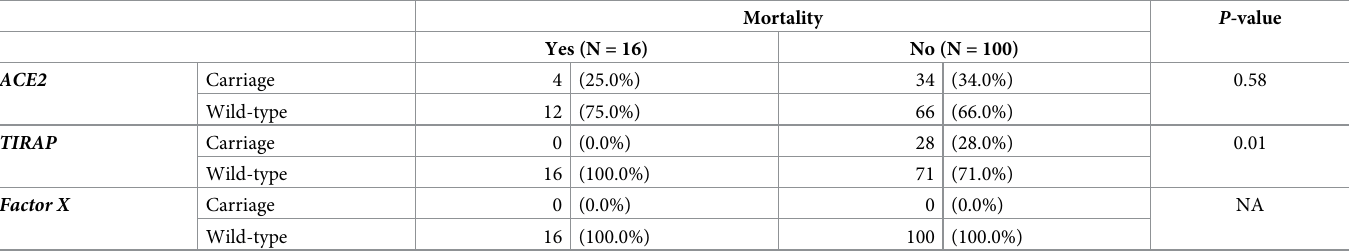
Table 3. Genotype frequencies in survivors and non-survivors.